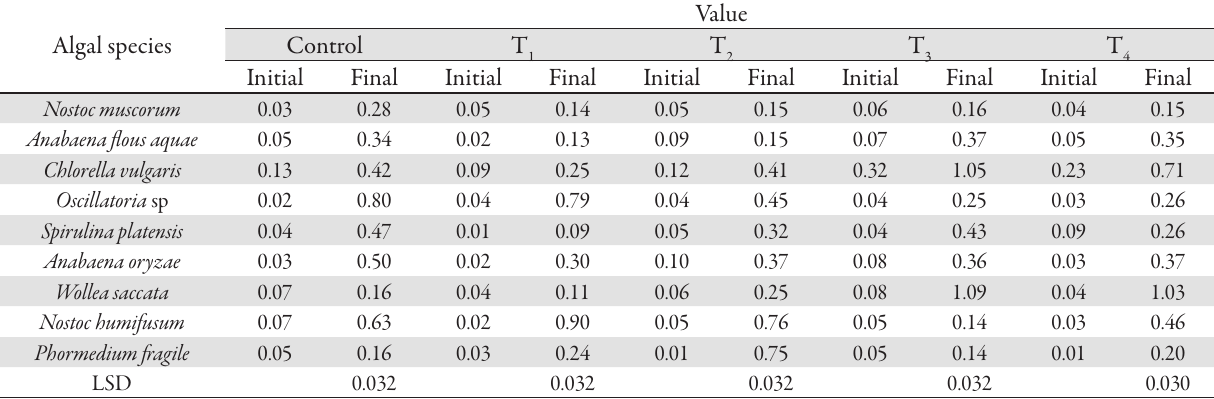
Tab. 5, 6 and 7 show optical density (OD), dry weight (DW) and chlorophyll content (mg l -1 ) of the microal- gal species cultivated in different wastewater treatments (T ,T , T andT ). 1 2 3 4 Tab. 5. Optical density of different microalgal species cultivated in different wastewater treatments Algal species